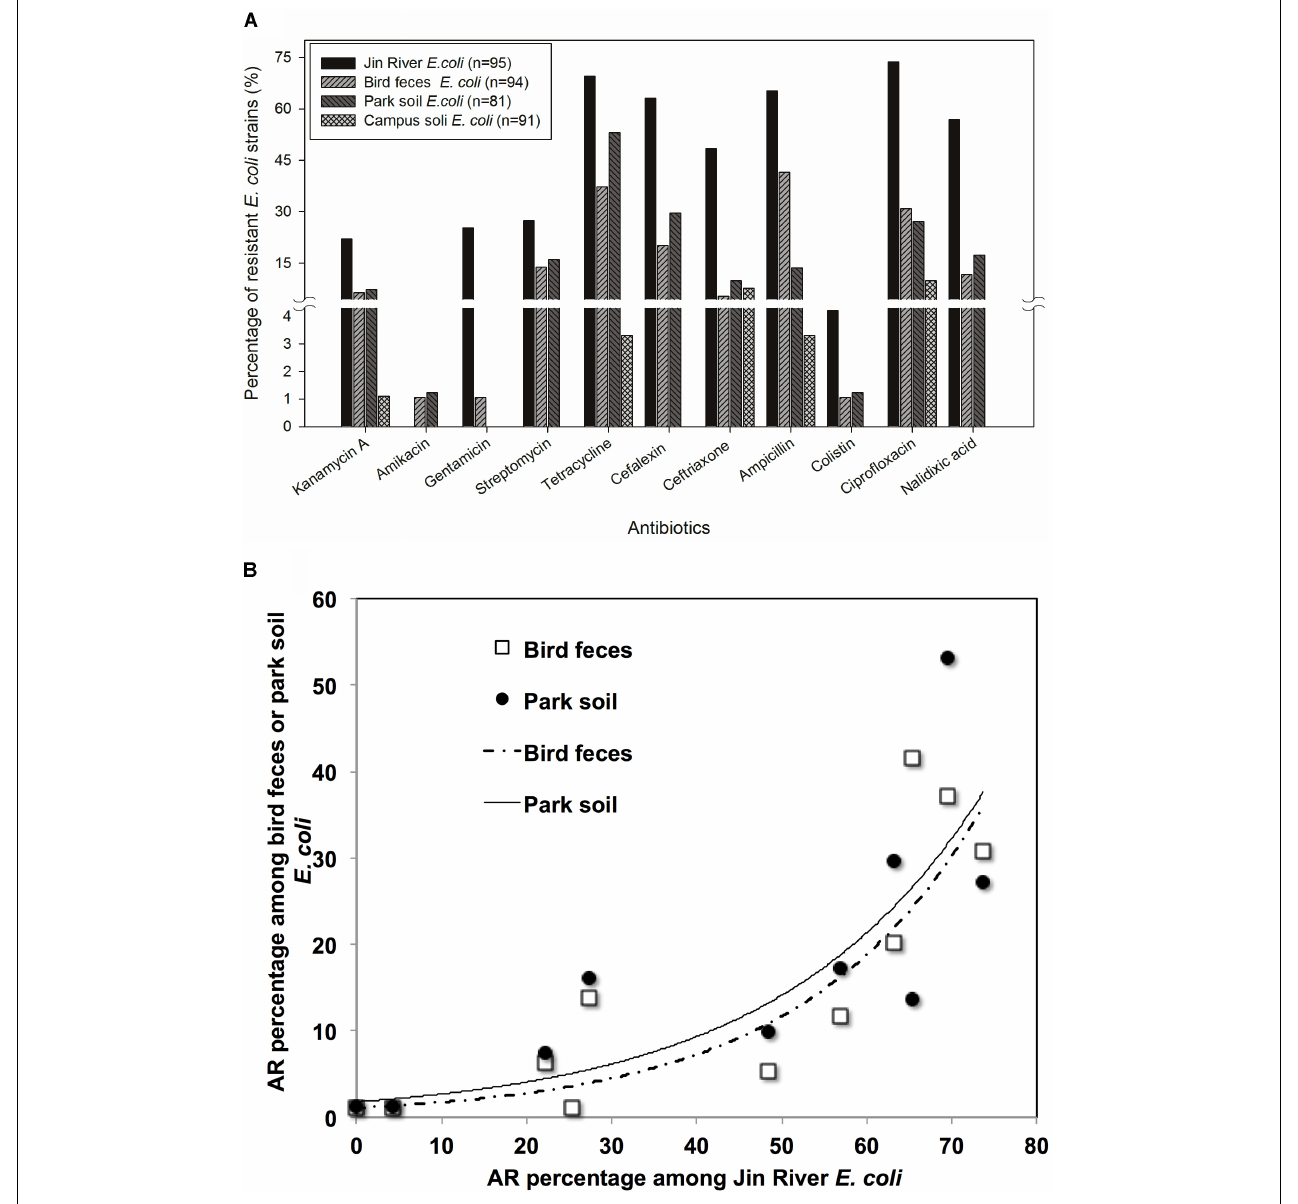
FIGURE 2 | The role of bird in the AR transportation was indicated with the AR rates (percentage) of environmental E. coli isolates (A) and the correlation of AR rates among the E. coli strains isolated from the environmental samples in related to egret inhabitation (B) . According to the paired-sample t -test of the AR rates (log-transformed) between the E. coli strains isolated from different environmental samples, the E. coli strains isolated from Jin River water exhibited the highest resistance rates to 11 antibiotics ( p < 0.01). The campus soil isolates gave the lowest resistance rates ( p < 0.01). The AR rates of the egret feces isolates were similar to those of the park soil isolates (A) . The resistance rates of the bird feces and park soil isolates to 11 antibiotics showed good exponential correlations ( R 2 > 0.77, p < 0.01) with those of the Jin River water isolates (B)